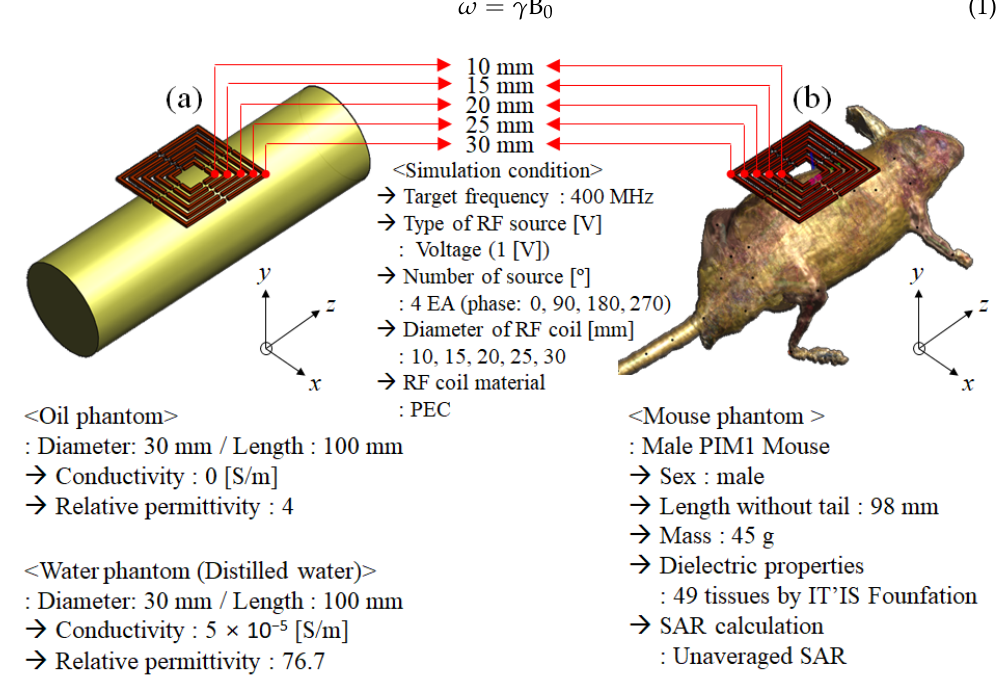
Figure 1. Geometric structures and simulation conditions of electromagnetic field simulation for the finite-different time-domain (FDTD) method using an oil phantom, water phantom, and mouse model: ( a ) oil phantom and water phantom with dielectric properties; ( b ) mouse phantom with dielectric properties.